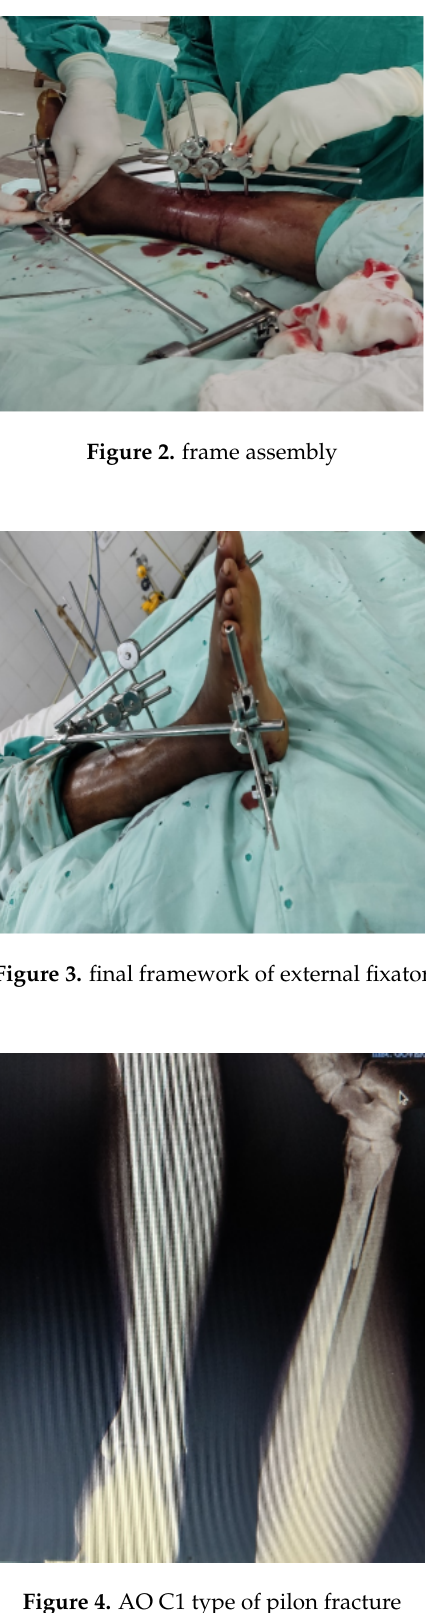
Figure 4. AO C1 type of pilon